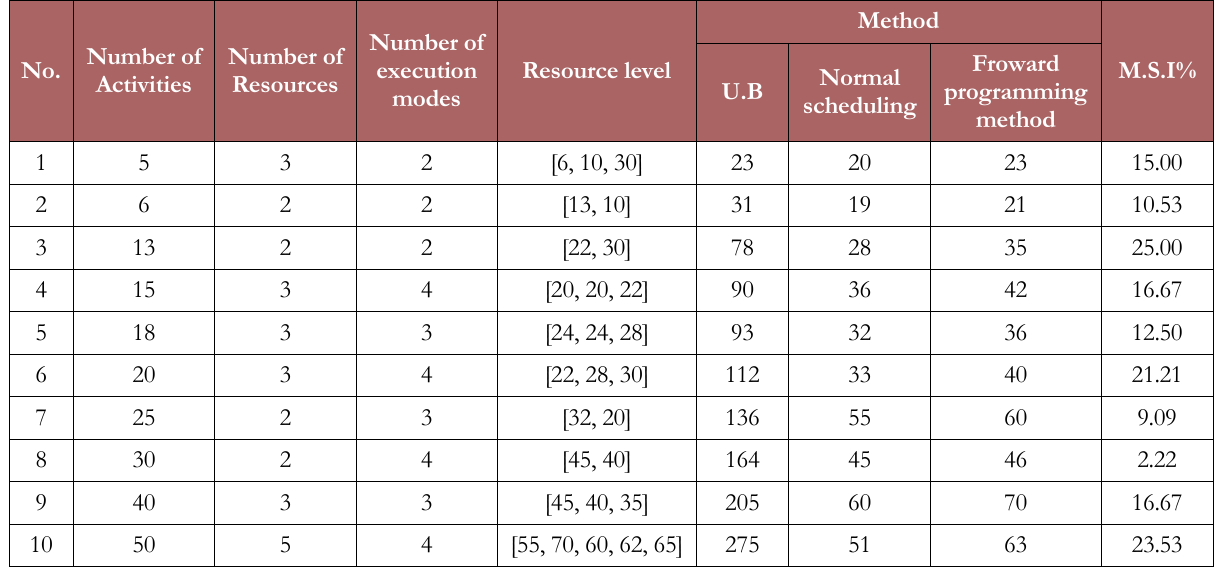
Table 3. Results gained after scheduling